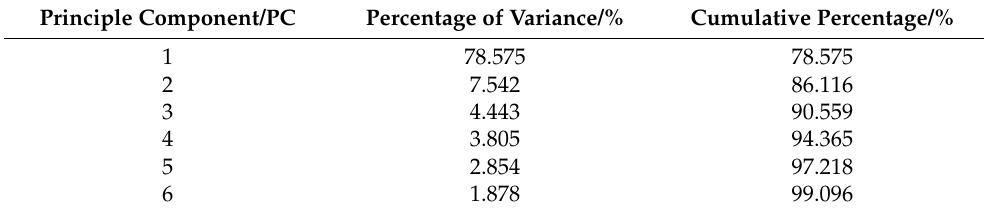
Table 5. Variance contribution percentage for PCs from